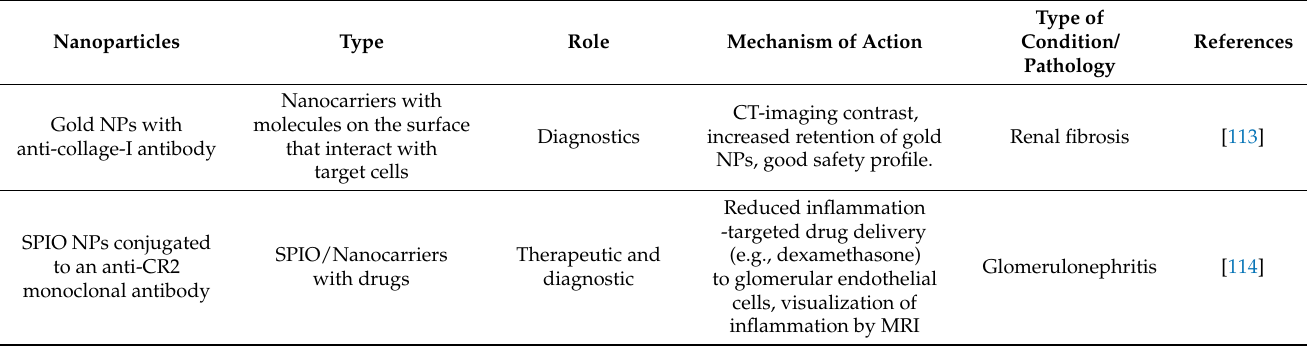
Table 2. Non-clinical studies of nanoparticles in kidney diseases and kidney